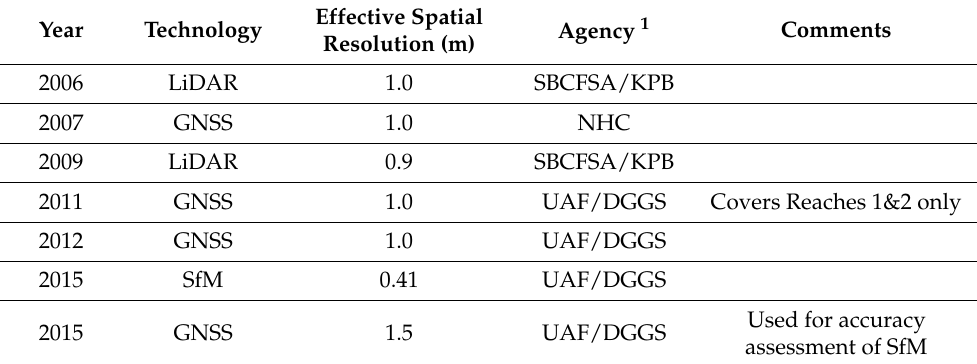
Table 1. Digital elevation models used for landslide inventory mapping and sedimentation analyses. The 2015 survey was not used to calculate volumetric changes but served as ground truth to the aerial survey and SfM DEM produced in 2015. The 2011, 2012, and 2015 DEMs were generated for this research. Effective Technology